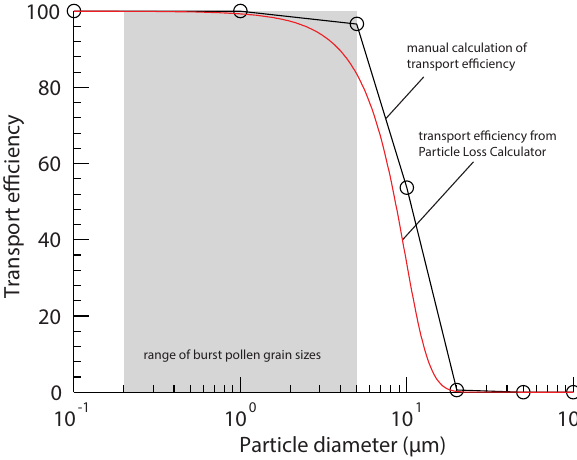
Figure A1. Particle transport efficiency as a function of particle size through the inlet of the SKC swirling aerosol collector. The black line is the calculated transport efficiency using Eq. (8)–(67) from Baron and Willeke (2001). The red line is the transport efficiency found using the Particle Loss Calculator (von der Weiden et al., 2009). The shaded grey area is range of particle diameters for burst pollen grains (Suphiopglu et al., 1992; Taylor et al., 2002).